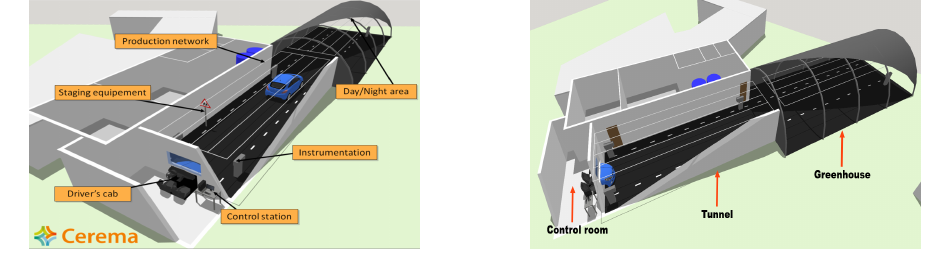
Figure 1. PAVIN fog and Rain platform